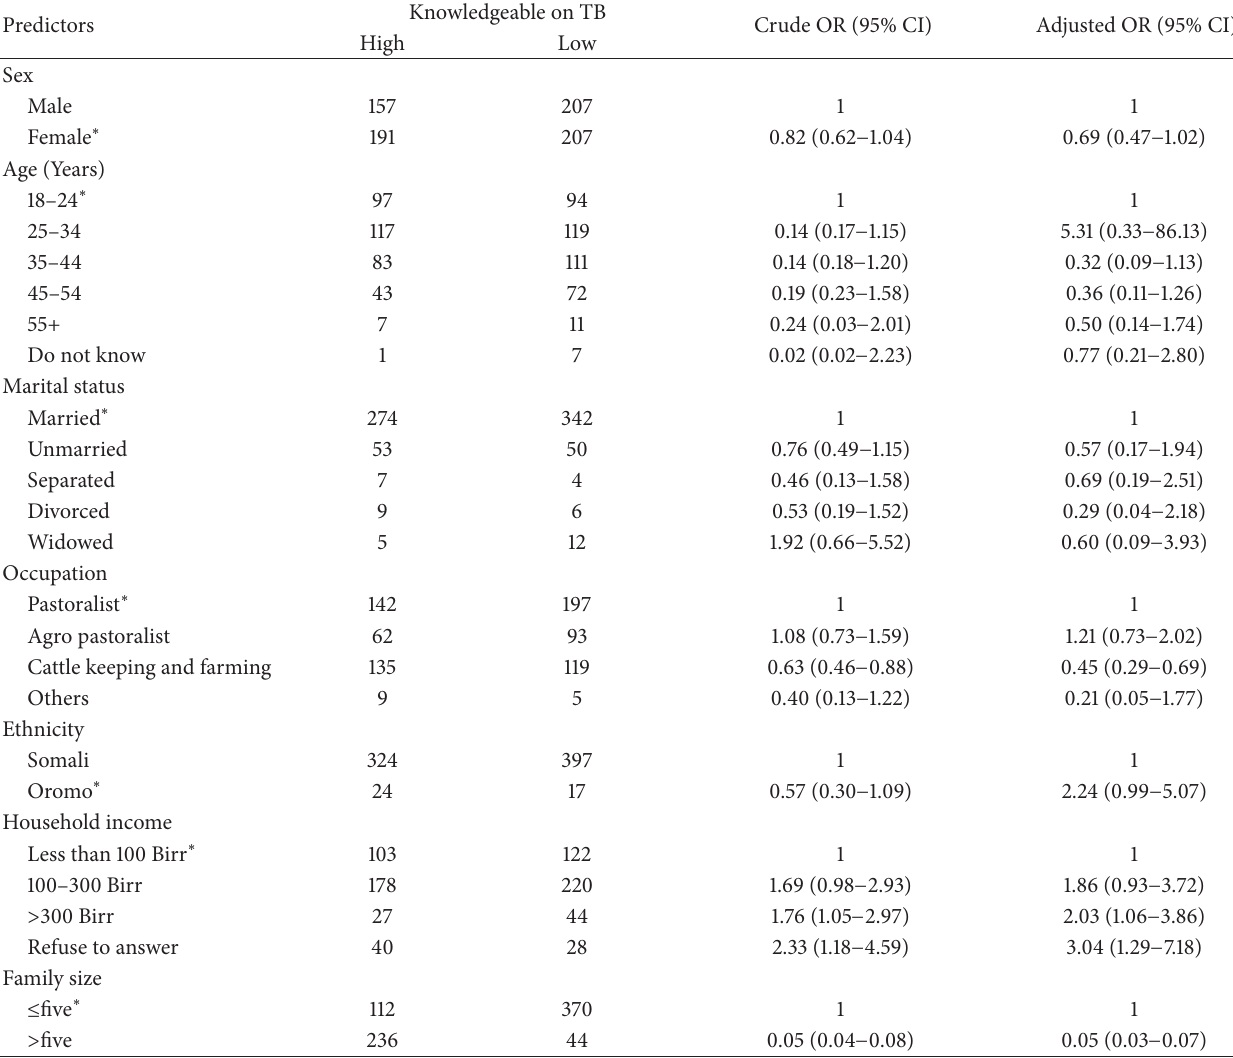
Table 6: Crude and adjusted odds ratio (OR) and 95% confidence intervals (CI) of determinants of TB knowledge.